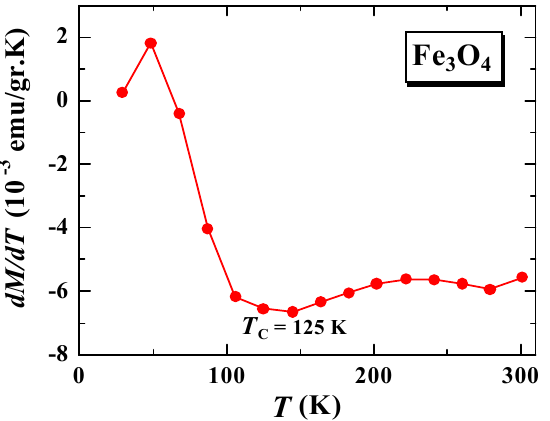
Figure 3. The first derivative curve of 𝑀 ( 𝑇 ) FC versus temperature of sample Fe 3 O 4 .